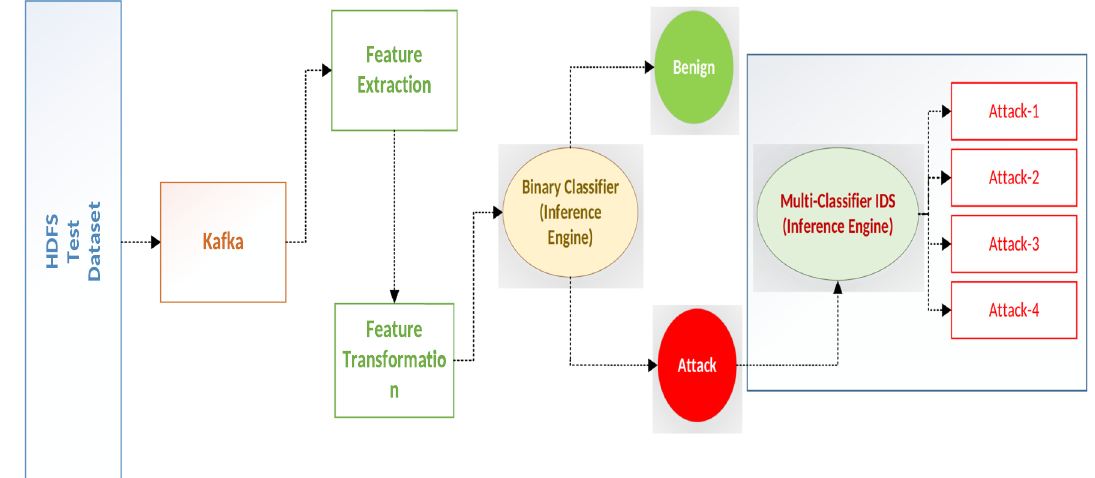
Fig. 8 Real time model